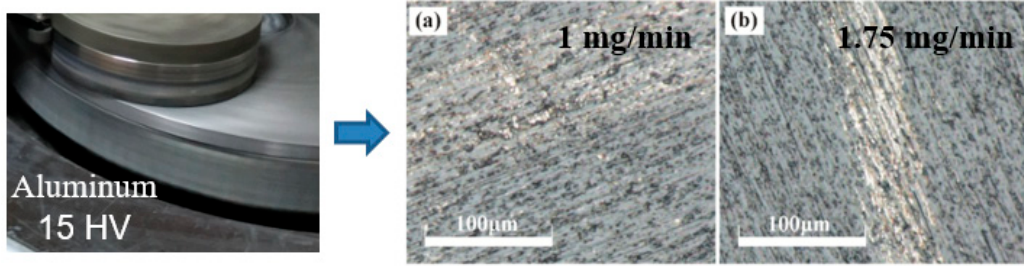
Figure 6. Optical images after lapping using copper disc: ( a ) common lapping; ( b ) ultrasonic-assisted lapping.